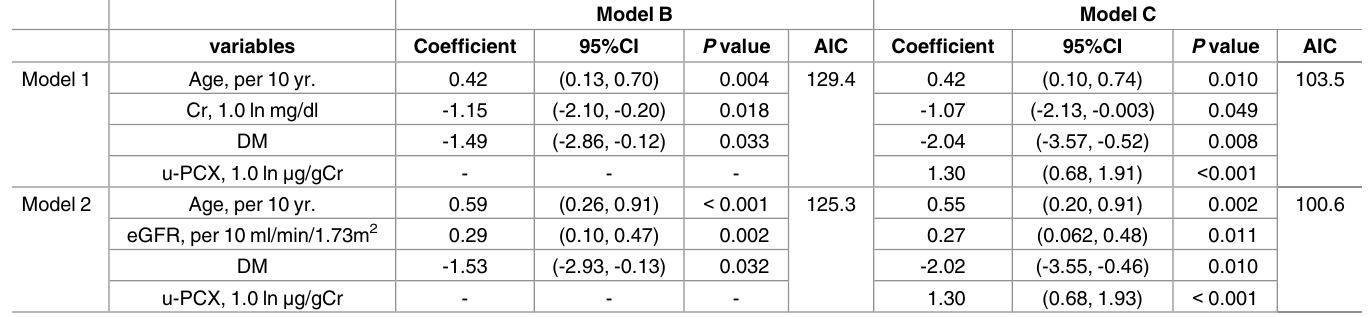
Table 2. Multiple models with a combination of clinical parameters and